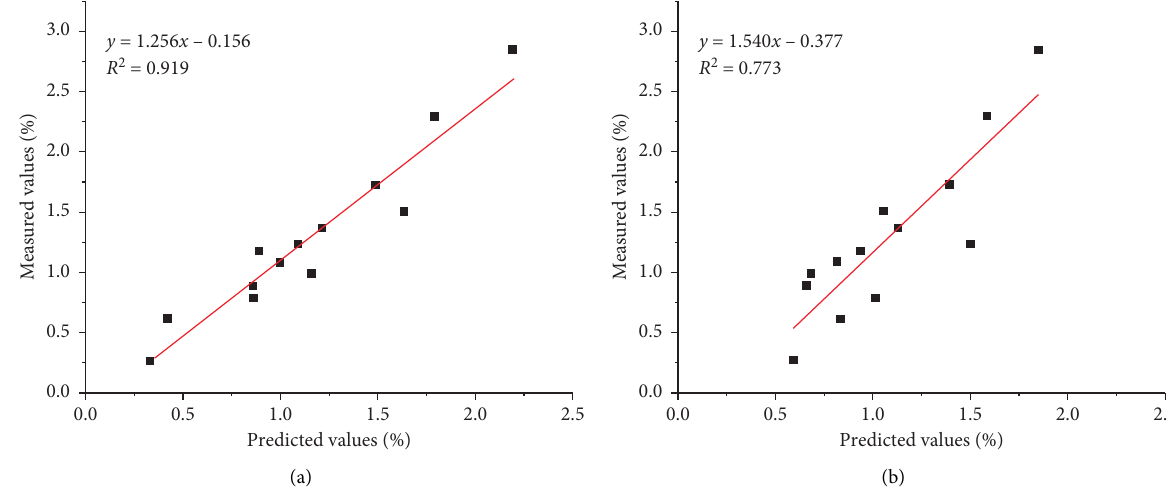
Figure 3: The external validation of the best ATR-MIR and NIR models. (a) The ATR-MIR model using the baseline preprocessing method. (b) The NIR model using the MN +SGS pretreatment method.